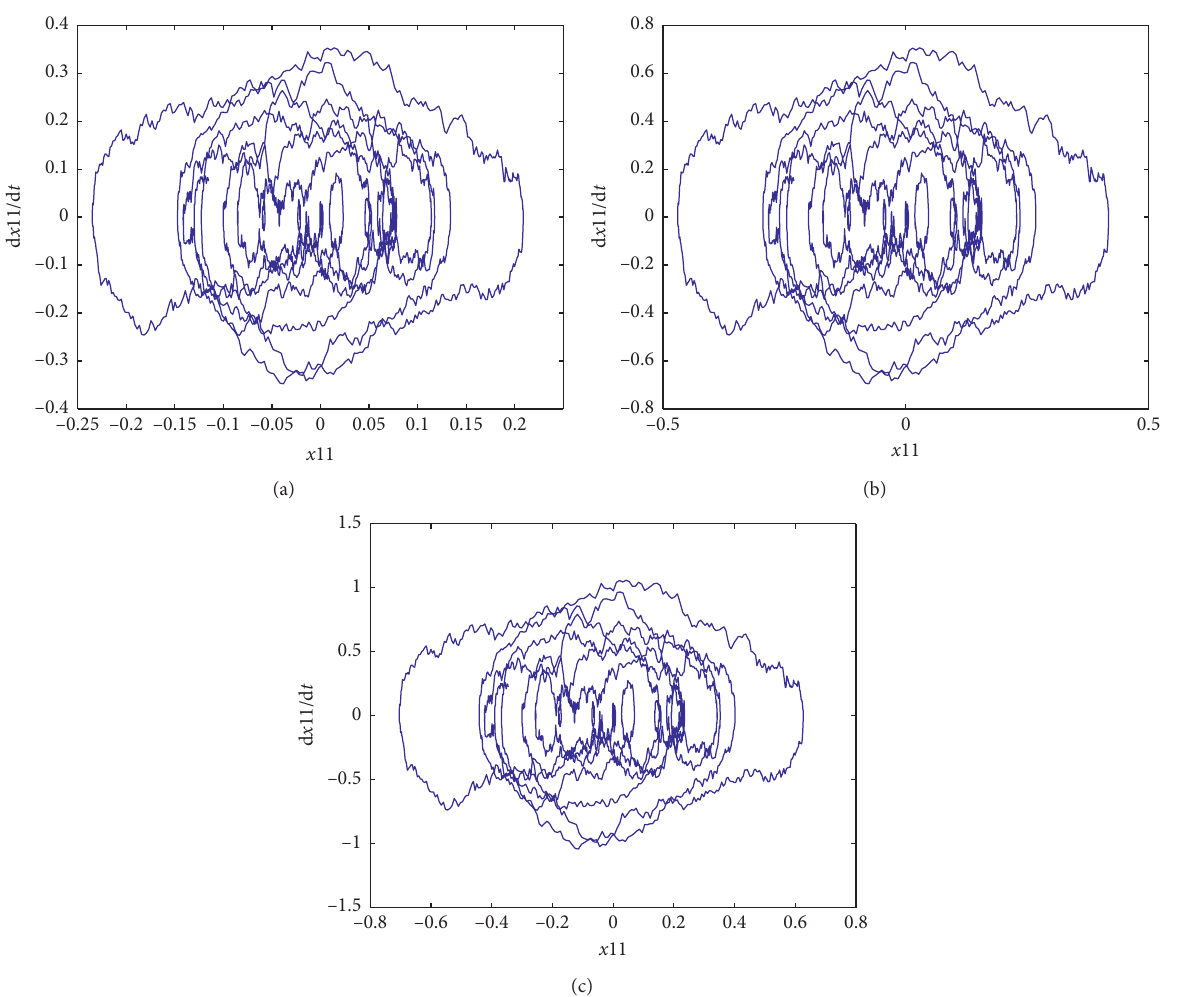
Figure 8: Phase portrait of horizontal displacement of 11 th story for passive case and different values of h ( x,t ) . (a) h ( x,t ) � 1. (b) h ( x,t ) � 2. (c) h ( x,t ) � 3.